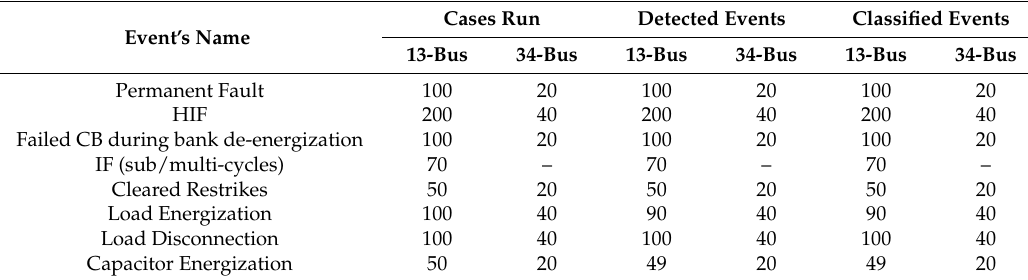
Table 5. Simulation